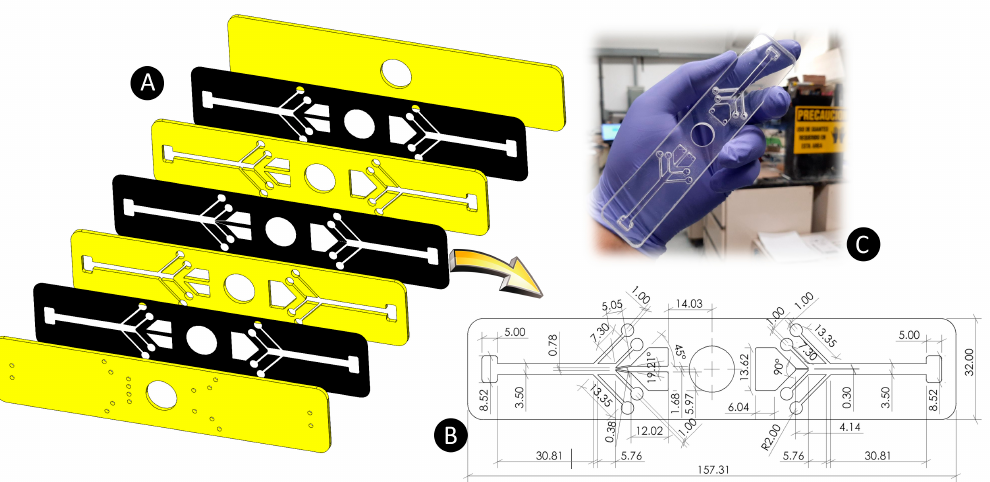
Figure 2. ( A ) Different layers of the microfluidic device, ( B ) the dimensions (mm), and ( C ) one of the fabricated devices. The three black layers represent the PSA, and the four yellow sheets show the PMMA.